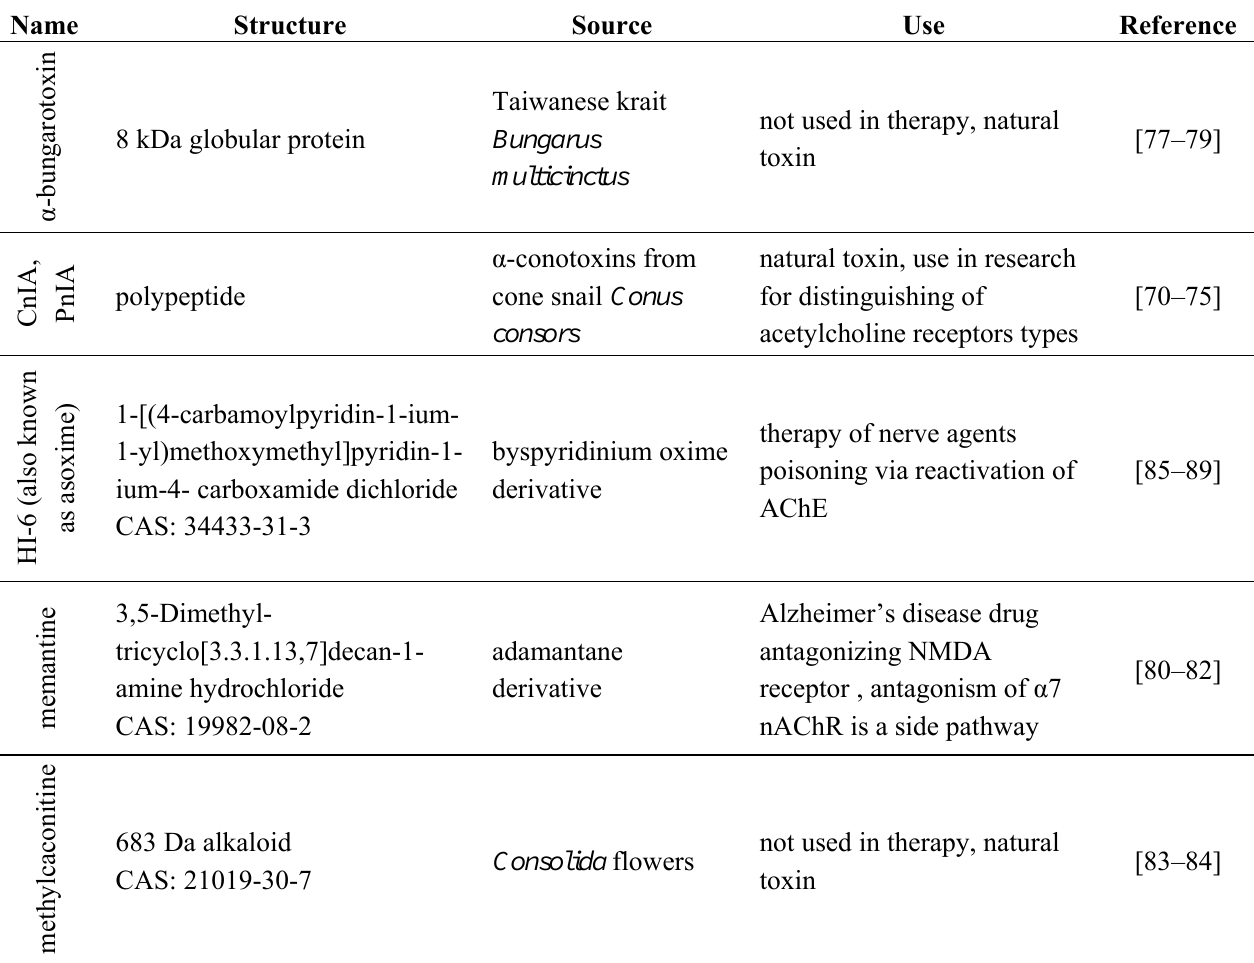
Table 1. Overview of selected α 7 nAChR